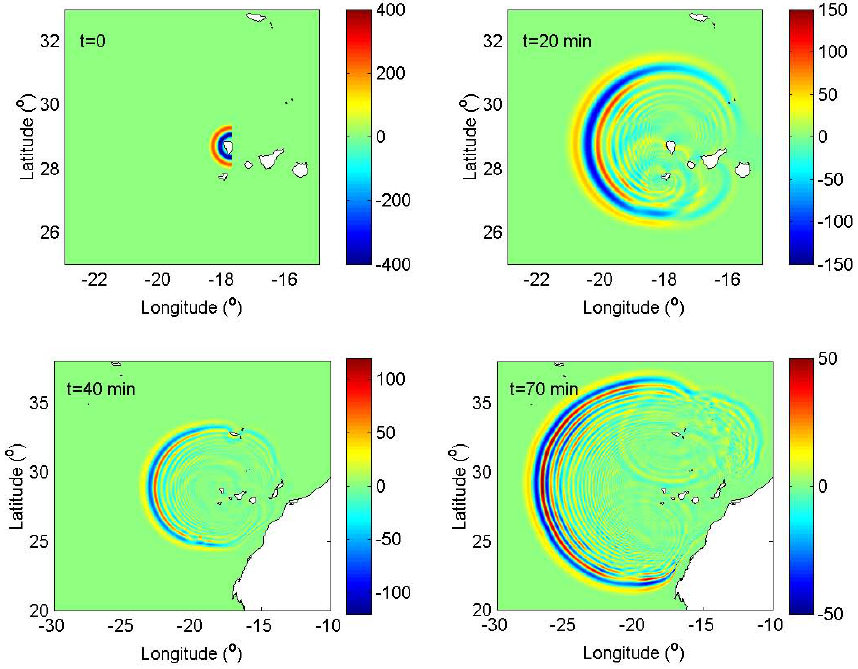
Fig. 20. Snapshots of the water surface in the vicinity of La Palma Island. Due to initial condition, more wave energy is projected westwards compared with the studies by Løvholt et al. (2008).